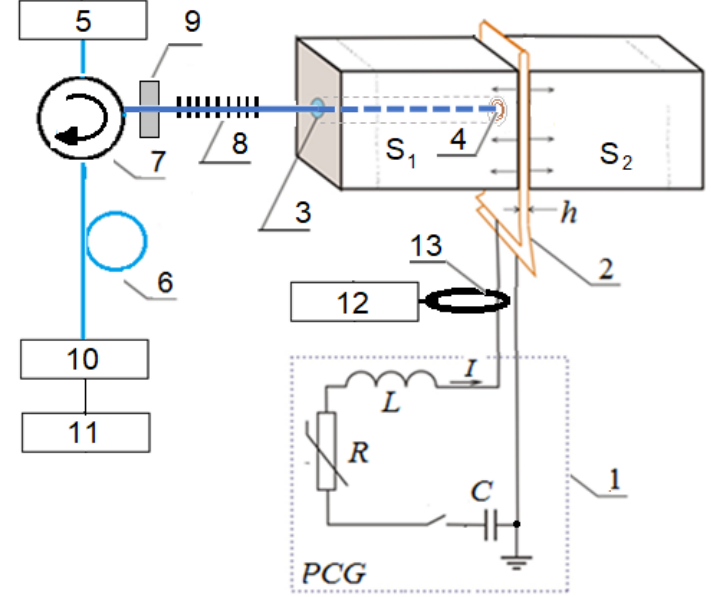
Figure 2. Scheme of the experimental setup: 1—the pulsed current generator; 2—conductor; S 1